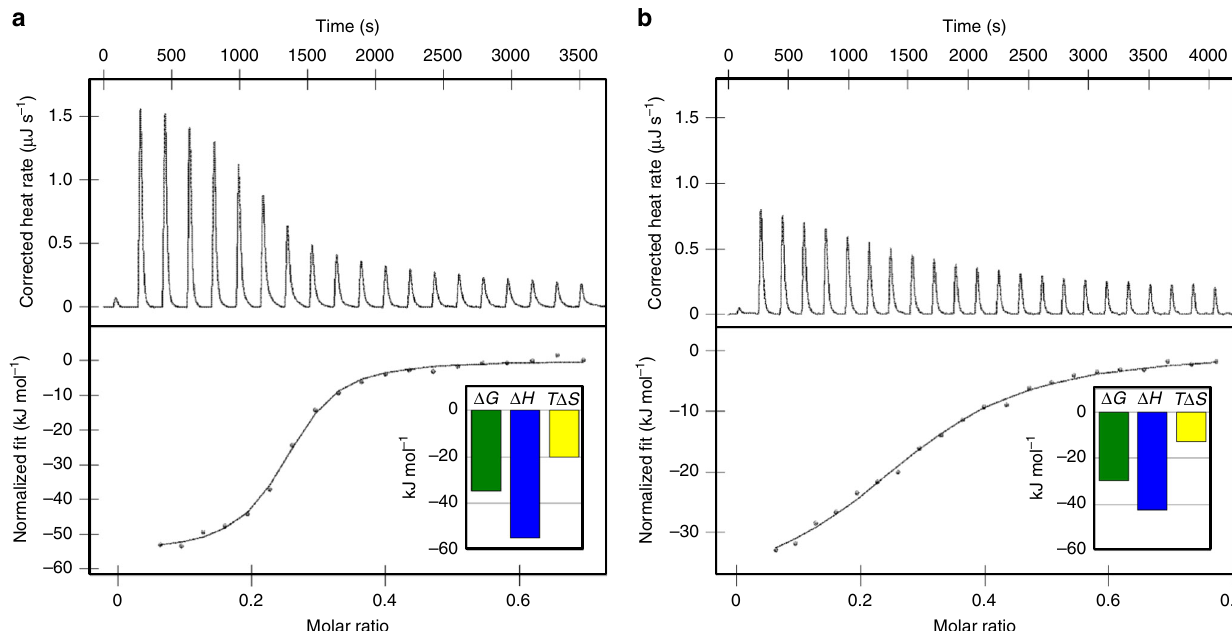
Fig. 1 Calorimetric analysis of the interaction of human RCC1 with importin α isoforms. Titration of 300 μ M RCC1 (in syringe) in a cell containing 100 μ M a Δ IBB-importin α 3 or b Δ IBB-importin α 1. Top panel : raw injection heats. Bottom panel : integrated, buffer-subtracted binding enthalpy plotted as a function of the RCC1:importin α molar ratio. Bottom panel insert : overall variation of enthalpy ( Δ H ), entropy ( T Δ S ), and Gibbs ( Δ G ) energy associated with each binding